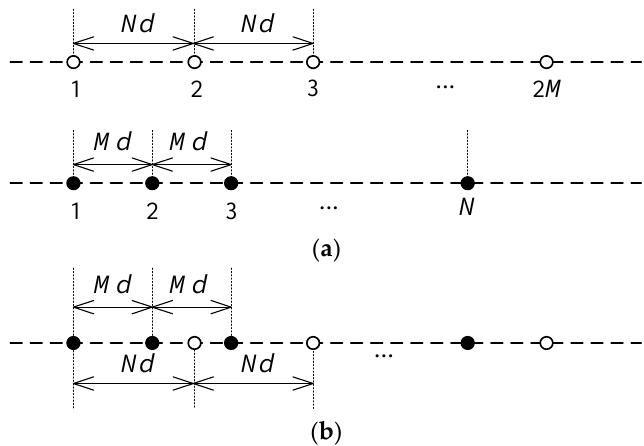
Figure 1. Illustration of an extended coprime array. ( a ) A coprime pair of sparse ULAs; ( b ) Coprime array configuration, which is a combination of the two sparse ULAs above.